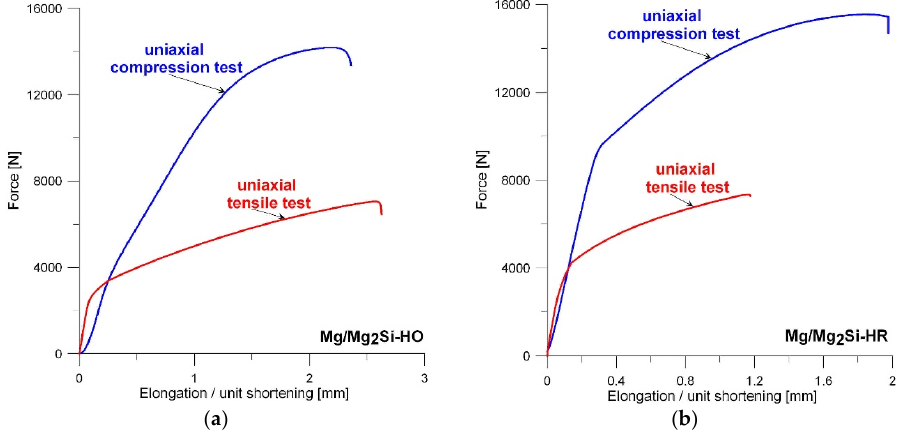
Figure 7. Representative tension and compression curves for the Mg/Mg 2 Si–HO ( a ) and Mg/Mg 2 Si–HR composites ( b ).